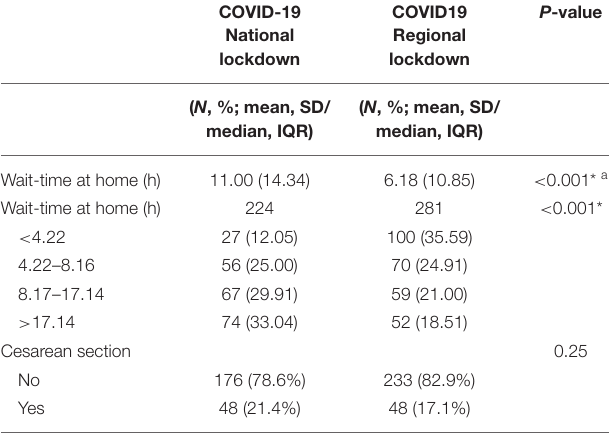
TABLE 1 | Characteristics of nulliparous women with PROM between COVID-19 national and regional lockdown